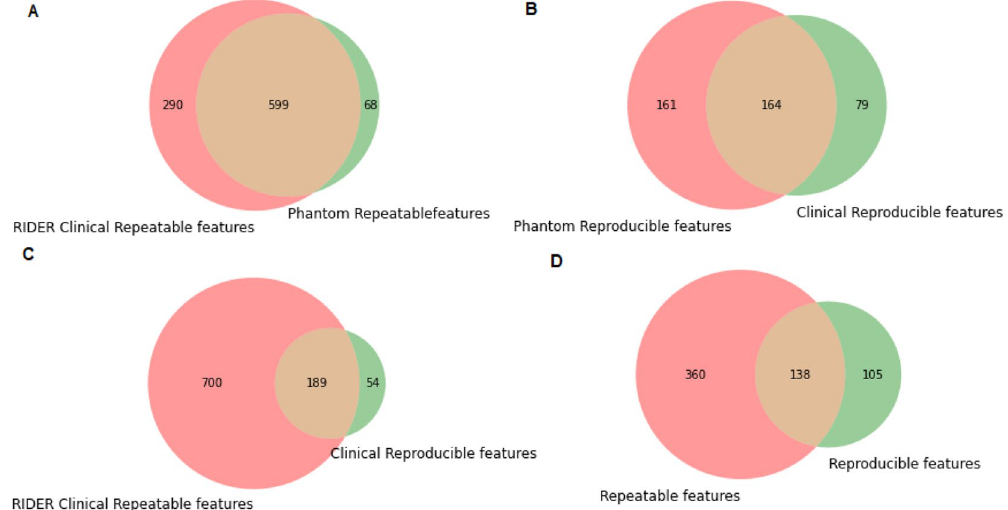
Figure 3. Common features in various studies showing good stability (ICC > 0.9): ( A ) Venn diagram shows the overlap of repeatability (RIDER) study and Phantom repeatability study. ( B ) Venn diagram shows the overlap of Phantom reproducibility study and reproducibility study in clinical cohort. ( C ) Venn diagram shows the overlap of repeatability (RIDER) study and reproducibility study in clinical cohort. ( D ) Overall summary of all the experiments. The Venn diagram shows the overlap of the repeatability experiment (phantom + clinical [RIDER] data) with the reproducibility experiments (phantom + clinical